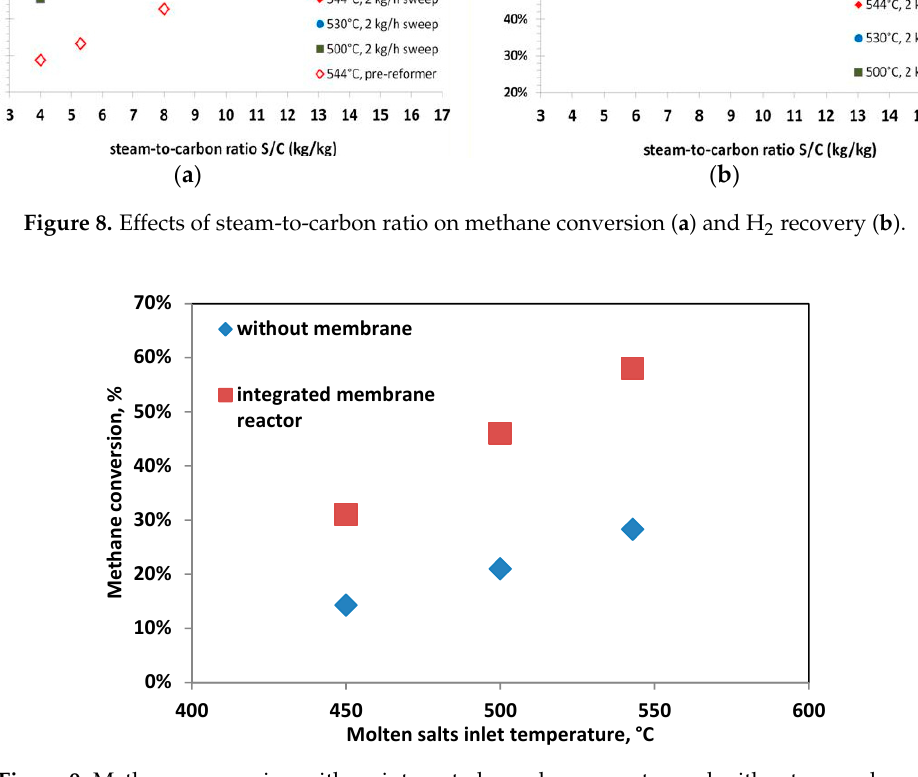
Figure 9. Methane conversion with an integrated membrane reactor and without a membrane.